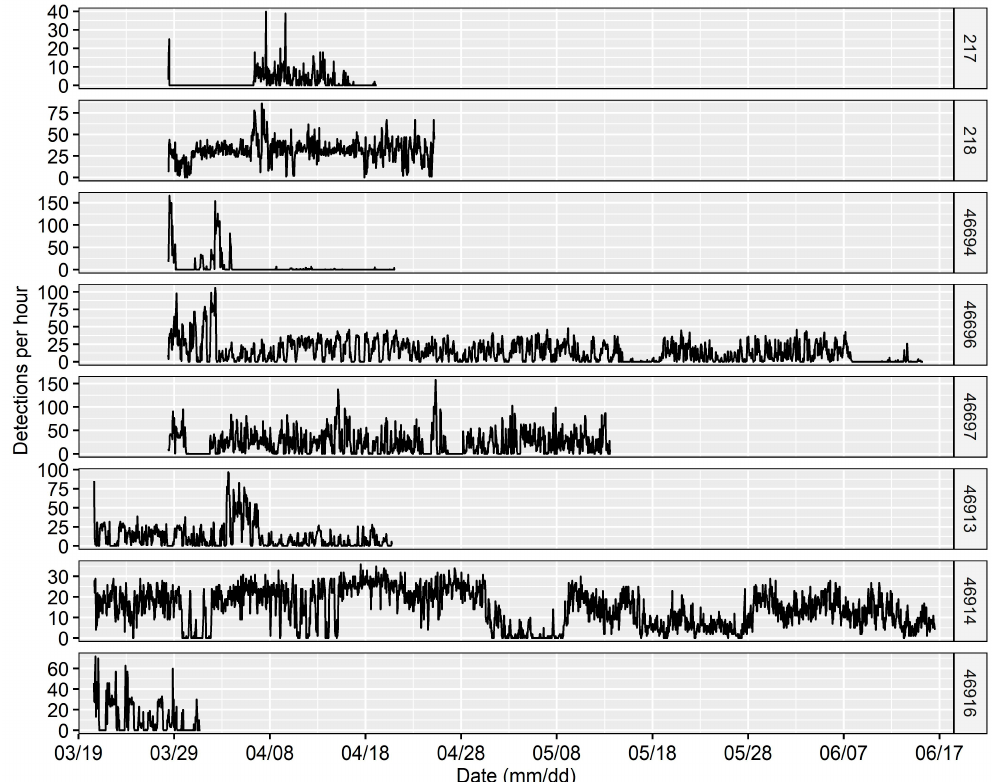
Figure 2. Hourly detection of each tagged fish during the study period from March to June 2017.